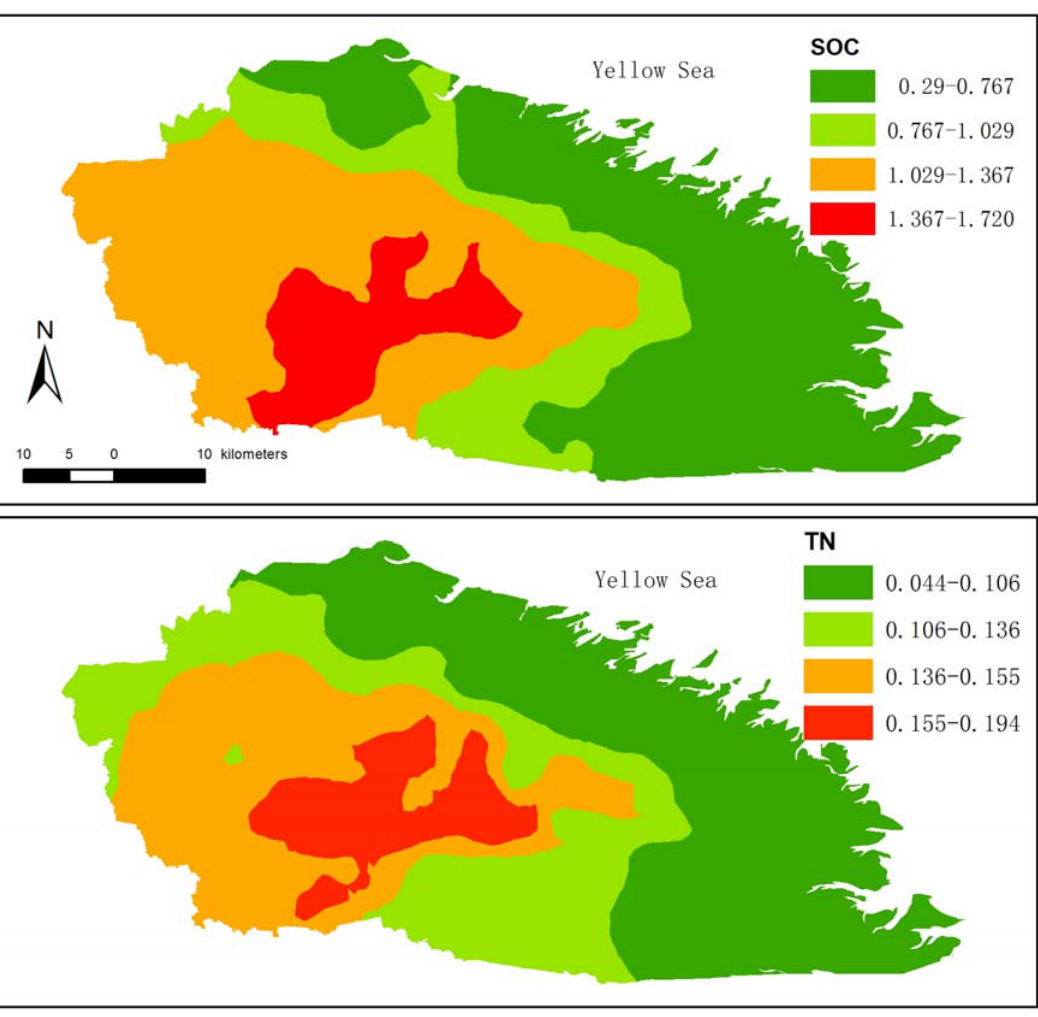
Figure 4. SOC (g · kg − 1 ) and TN (g · kg − 1 ) mapping of Rudong Figure 4. SOC (g ∙ kg − 1 ) and TN (g ∙ kg − 1 ) mapping of Rudong County.